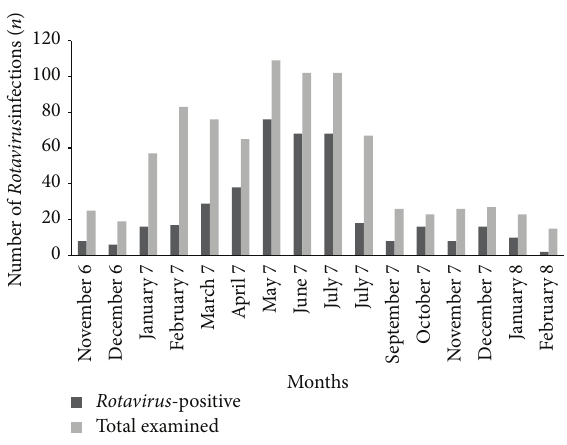
Figure 1: Monthly seasonality of Rotavirus diarrhea among children in Taiz,